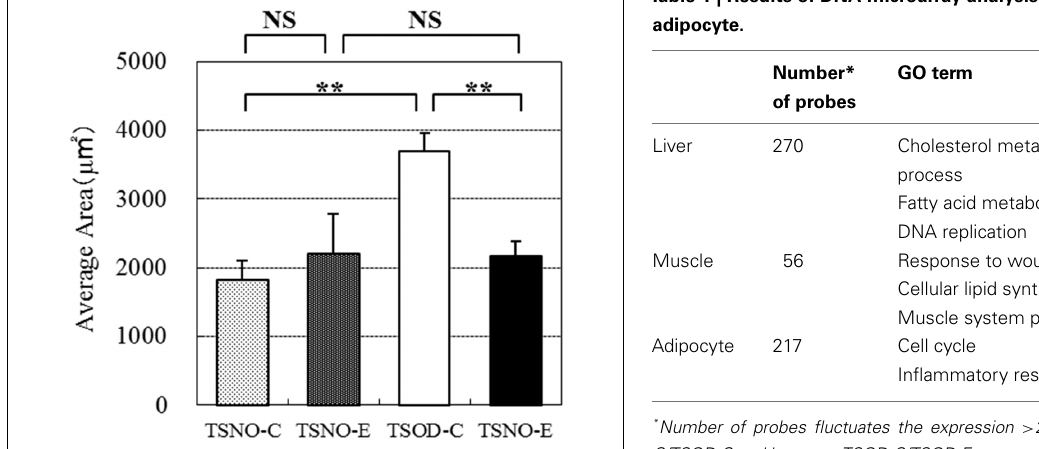
FIGURE 6 | Comparisons of individual adipose area. Average areas of each epididymal cell were calculated and compared.Two asterisks indicate the p value less than 0.01 and NS indicate no significance between the groups.